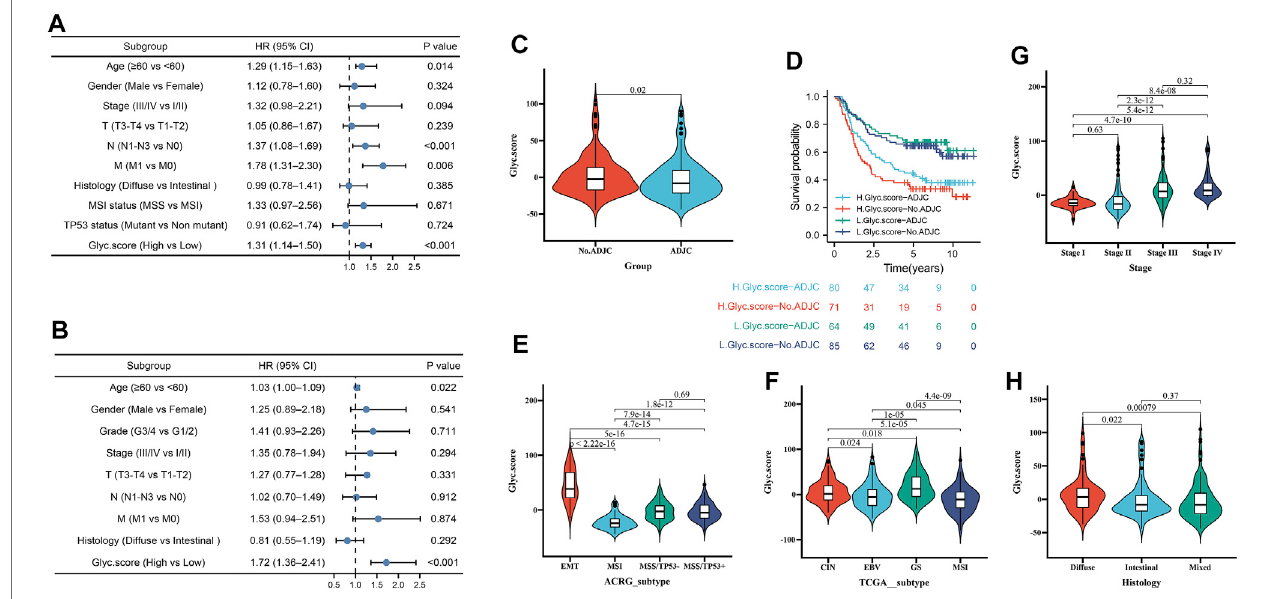
FIGURE 6 | Independent prognostic analysis of Glyc. score. (A) Multivariate Cox regression analysis for Glyc. score in ACRG cohort shown by the forest plot. (B) Multivariate Cox regression analysis for Glyc. score in TCGA cohort shown by the forest plot. (C) Difference in Glyc. score among ADJC and No. ADJC in ACRG cohort. ADJC,adjuvantchemotherapy. (D) Kaplan – MeiercurvesforpatientsintheACRGcohortstrati fi edbybothreceiptofADJCandGlyc.score. (E) DifferencesinGlyc.score between different ACRG molecular subtypes. The upper and lower ends of the boxes represented interquartile range of values. (F) Differences in Glyc. score between different TCGA-STAD molecular subtypes. The upper and lower ends of the boxes represented interquartile range of values. (G) Differences in Glyc. score between different stage. (H) Differences in Glyc. score between different histology subtypes.